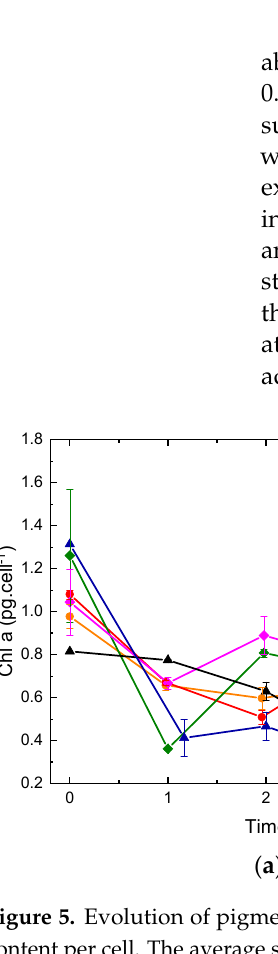
Figure 7. Dependence of 𝐹 (cid:2868) on biomass concentration of samples collected at the end of the expo- nential phase and their dilutions, for batch experiments. Error bars are the standard deviation among four wells at the same concentration. 3.2. Results of the Biomass Concentration Estimation The models described in Section 2.2.3 were used to predict biomass concentration. Note that the same model is used to predict biomass concentration at three different light intensities and at three different times (days) in the dynamic batch cultivation curve. Detailed results are reported in Table 2. At first, it can be seen that using the logarith- mic model C[ 𝐗 𝐂𝐈 ‖ ln(C x )] helps reducing the average relative error with respect to C[ 𝐗 𝐂𝐈 ‖ C x ], while the average absolute error remains almost unchanged. Comparison be- tween C[ 𝐗 𝐂𝐈 ‖ ln(C x )] and C[ 𝐗 𝐅𝐈 ‖ ln(C x )] confirmed that using only fluorescence measure- ments as predictors may lead to large errors in the prediction of biomass concentration. For the sake of completeness, it must be noticed that the biomass concentration range is quite wide (10–90×10 6 cell·mL − 1 ) with respect to ranges usually adopted in literature for